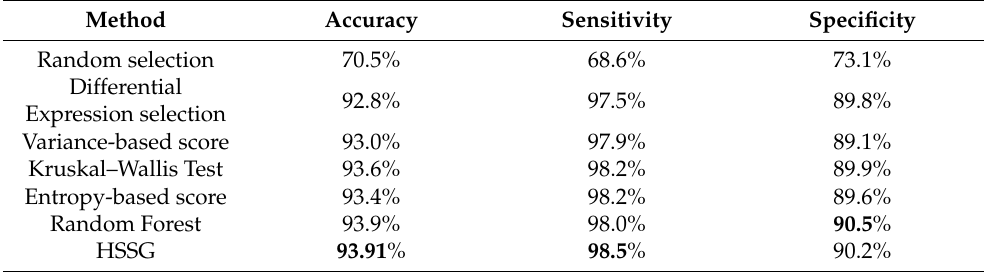
Table 2. Comparison with six popular feature scoring methods in selecting 67 genes.